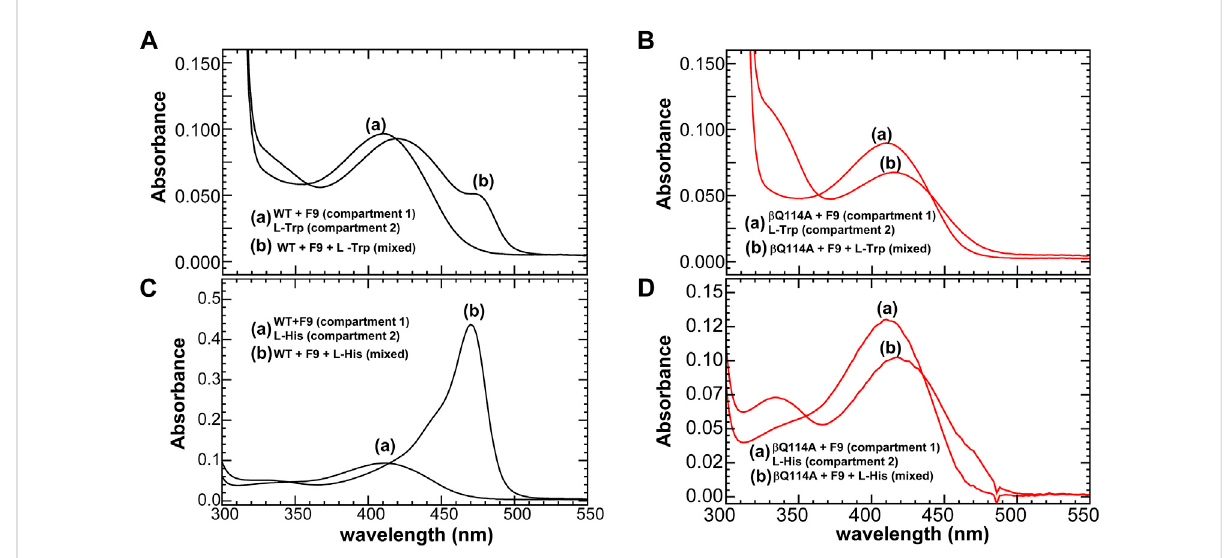
FIGURE 11 Reactions of WT and β Gln114Ala TS, respectively with L-Trp (A,B) , and with L-His ( 16 ) (C,D) . A double-difference quartz cuvette was used to acquire thespectra. In each panel, the solutions in thetwo compartmentsof the cuvette are designated as follows: (A) spectra before mixing and (B) spectra following mixing. Color code: black WT, and red β Gln114A. All the reactions were carried out in the presence of α site ligand F9. Figure redrawn from Ghosh et al.